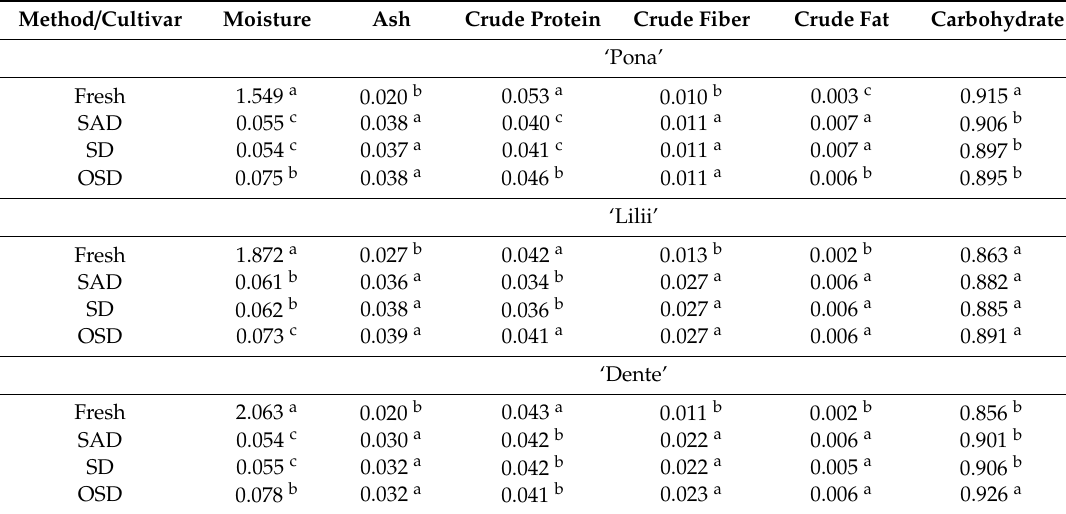
Table 2. Composition (kg / kg dry matter) of the three cultivars (fresh and dried) at di ff erent drying